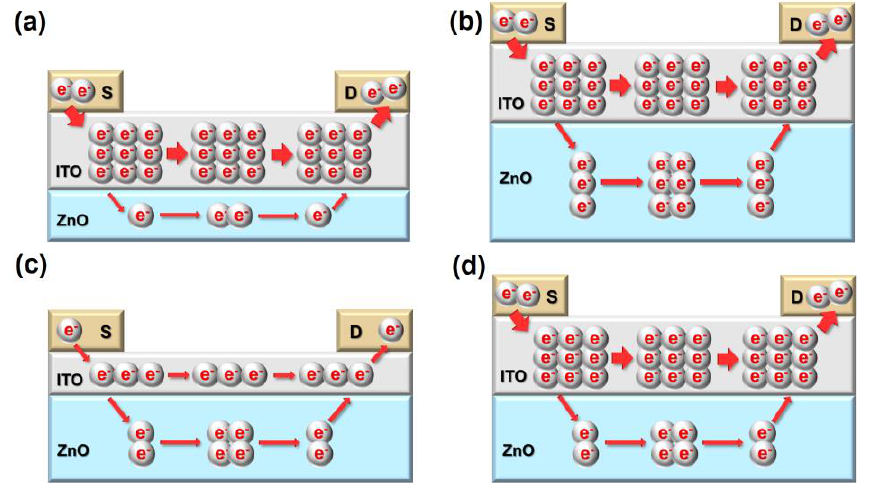
Figure 9. Schematic diagrams of current conduction in channel structures of ( a ) ZnO/ITO (10 nm/9 nm), ( b ) ZnO/ITO (40 nm/9 nm), ( c ) ZnO (25 nm)/ITO ( ≤ 5 nm), and ( d ) ZnO (25 nm)/ITO (>5 nm).